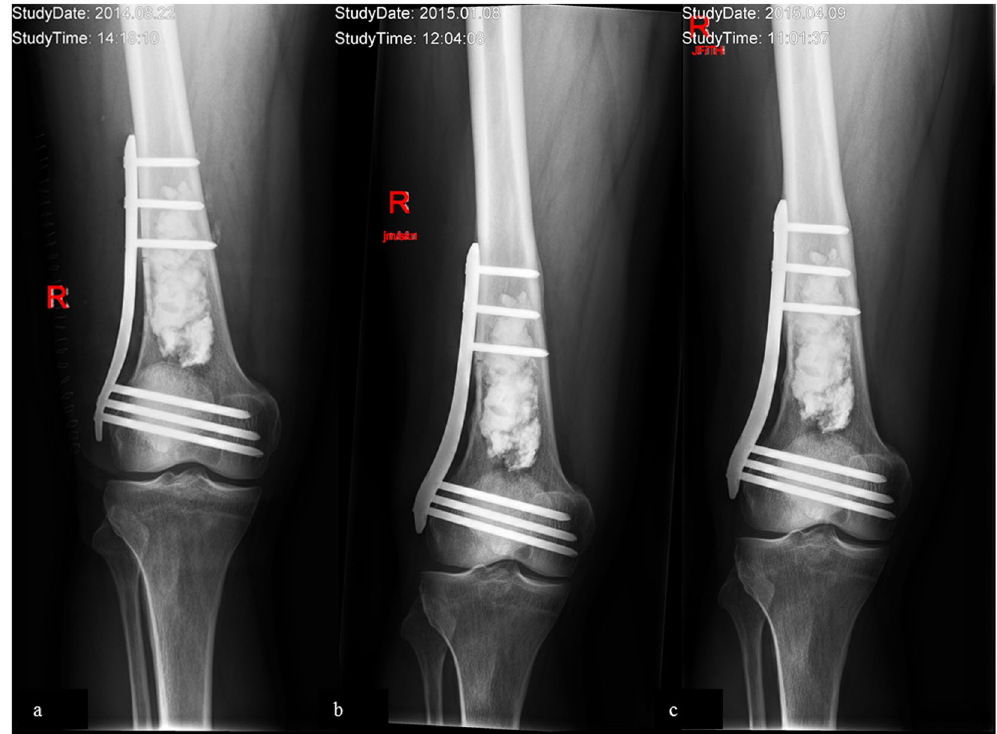
Figure 2. ( a – c ) X-ray of a 64 year-old male patient few days following curettage of an enchondroma of the right distal femur. To enhance primary stability, a plate osteosynthesis was done. ( b and c ) Follow-up x-rays 5 and 11 months following index surgery showing integration but no resorption of the bone graft